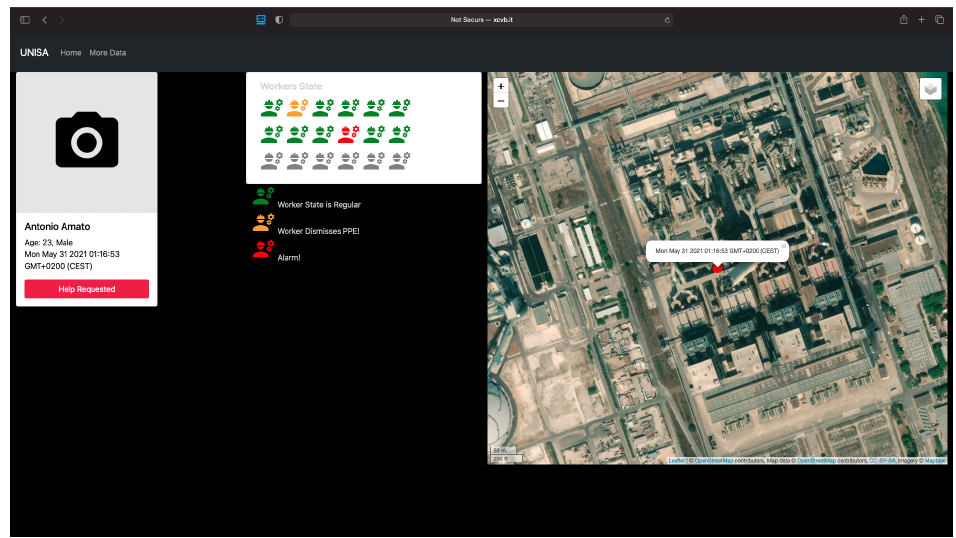
Figure 16. The Web application